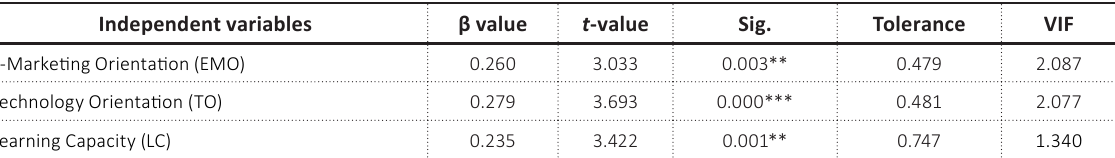
Table 3. Regression analysis